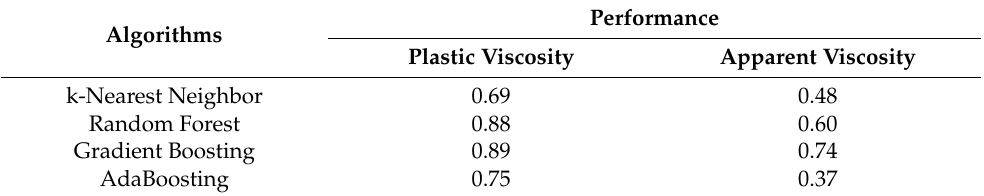
Figure 13. Predicted vs. actual values of ( a ) PV and ( b ) AV of the testing dataset for different algorithms (GB: Gradient Boosting, RFR: Random Forest, AB: AdaBoosting, kNN: K-Nearest Neighbor) for low shear rate. Table 3. Performance of algorithms in predicting plastic and apparent viscosity (R 2 ).